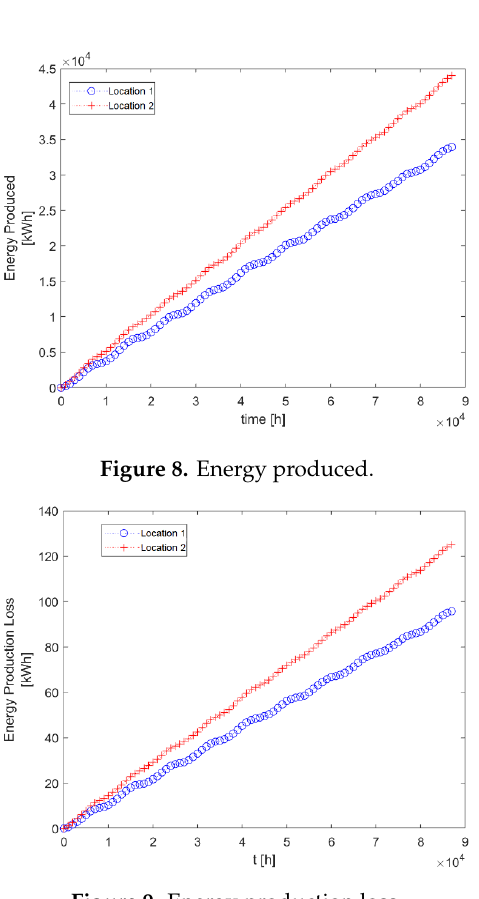
Figure 9. Energy production loss.